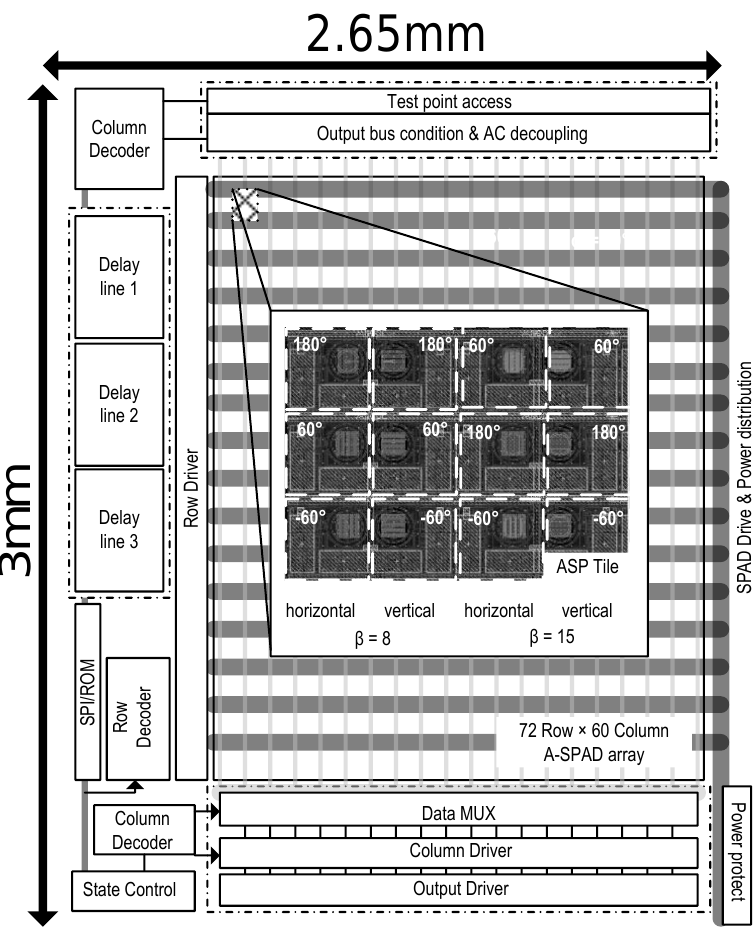
Figure 8. System architecture of a 72 × 60 A-SPAD